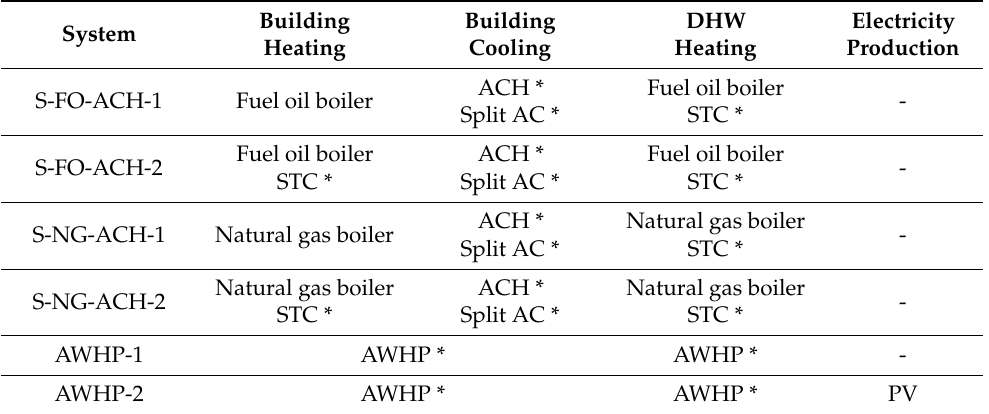
Table 2. HVAC systems considered in the